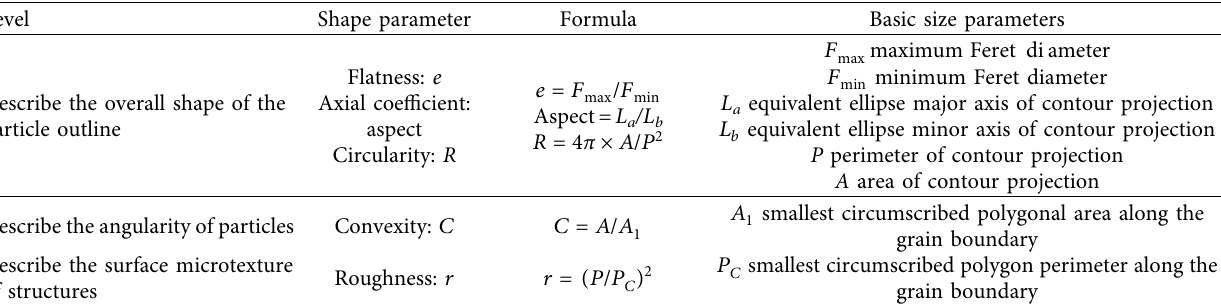
Figure 4: Schematic of basic particle size parameters. Table 1: Particle shape parameters.